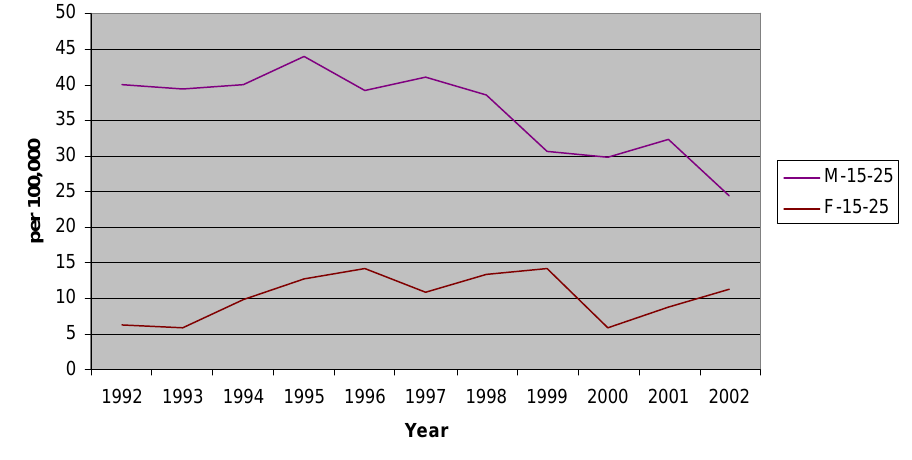
FIGURE 6. Youth suicide, age 15–25. Source: NZHIS.